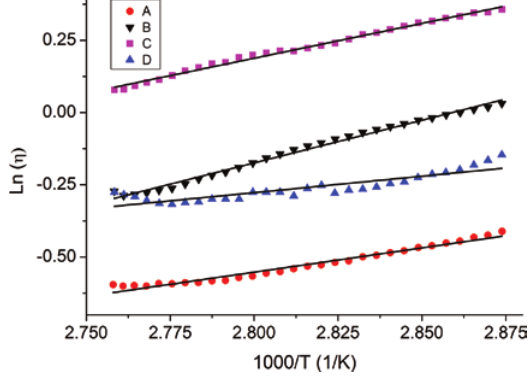
Figure 6 Plot of Ln( η ) versus 1000/T for the prepared feedstocks.